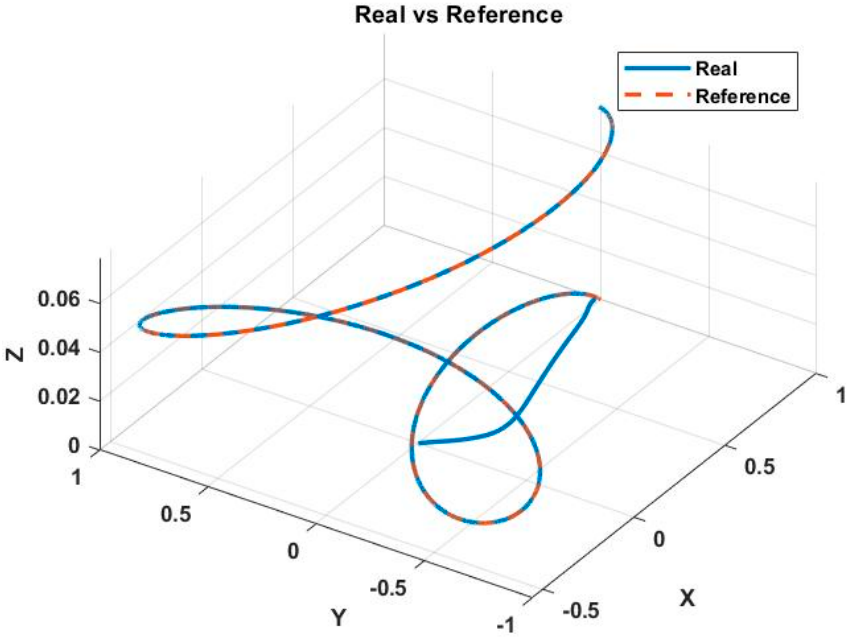
Figure 8. Real trajectory ( 𝑋 𝐵𝑙𝑢𝑒 𝑆𝑜𝑙𝑖𝑑 𝑙𝑖𝑛𝑒 ) vs. desired trajectory ( 𝑋𝑑 𝑅𝑒𝑑 𝑑𝑜𝑡𝑡𝑒𝑑 𝑙𝑖𝑛𝑒 ).